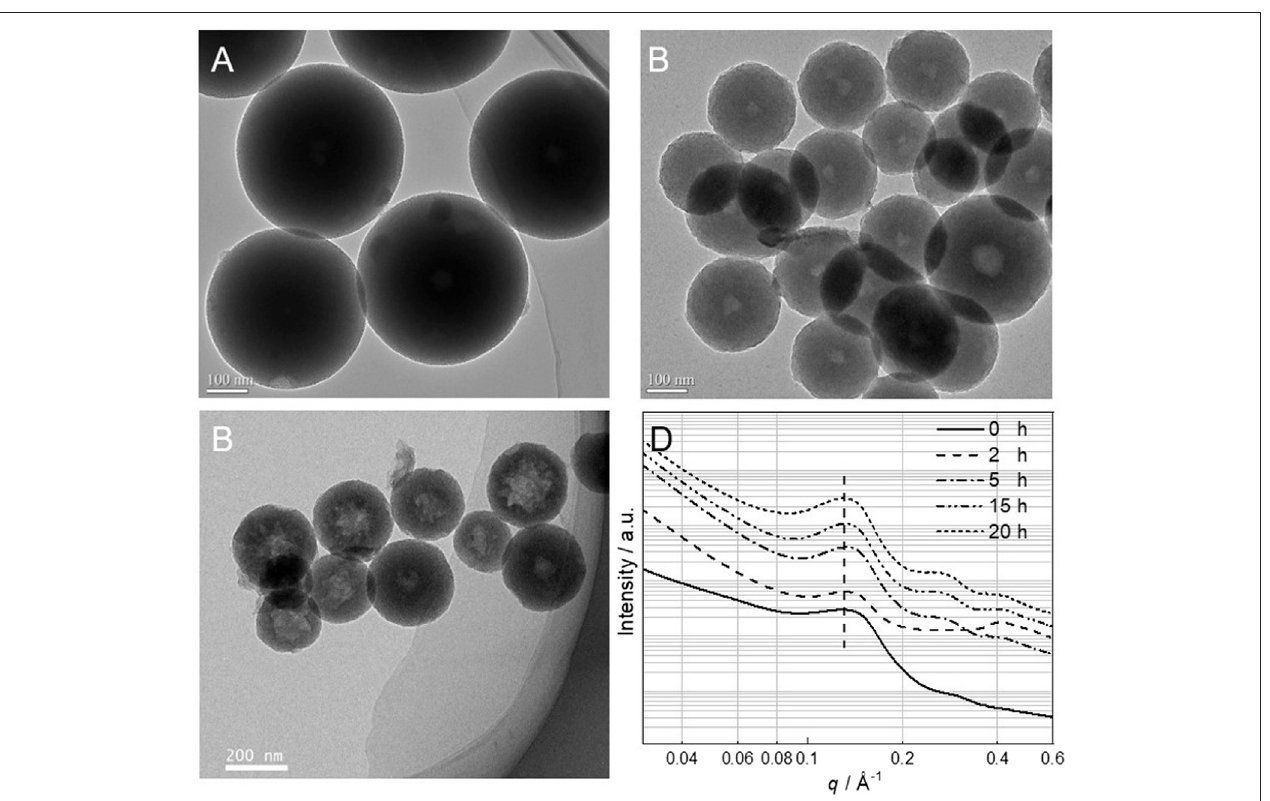
FIGURE 4 | TEM images of m SiO 2 under different etching times (A) 0 h, (B) 2 h, (C) 15 h, (D) SAXS images of m SiO 2 under different etching times.